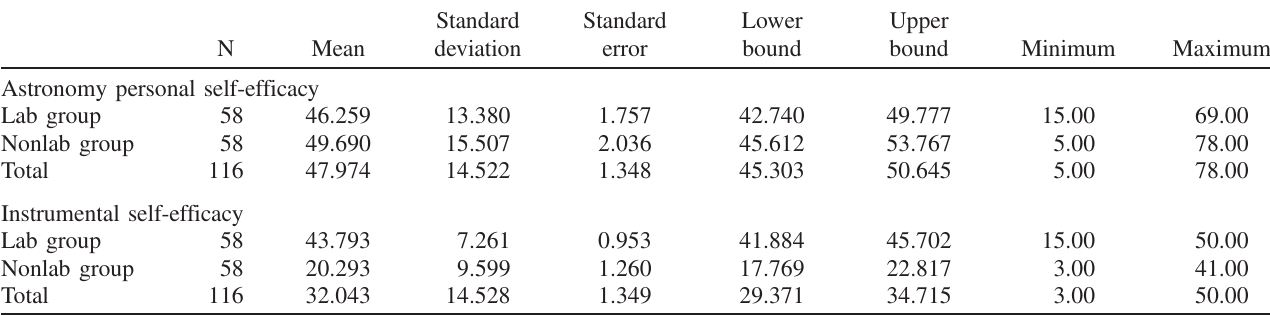
TABLE VII. Descriptive statistics of APSE and ISE for cohort A and cohort B.